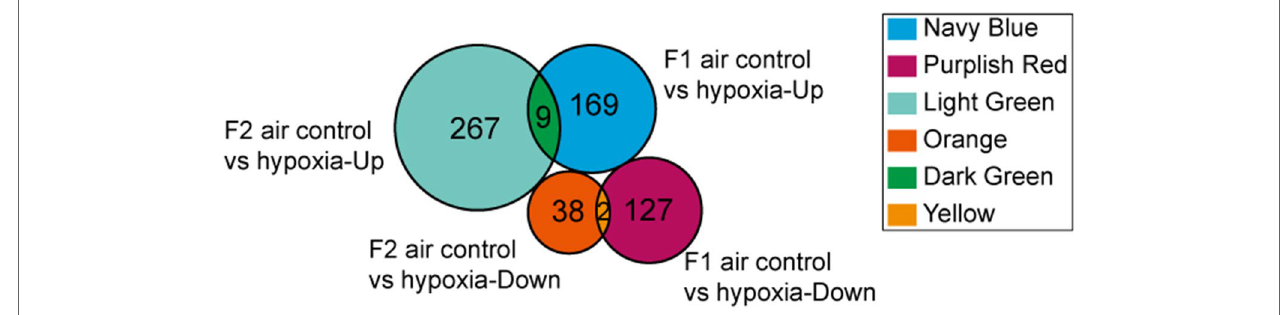
FIGURE 5 | Venn diagram showing “Heredity” DEGs: Among the 296 genes classified as “Loss,” 169 were up-regulated (navy blue part) and 127 were down- regulated (purplish red part). Similarly, among the 305 genes defined as “Gain” 267 were up-regulated (light green part) and 38 were down-regulated (orange part). Overall, only 11 DEGs (“Heredity”) were identified to be expressed in both the F1 and F2 generations and had a similar trend of gene expression (dark green and yellow part).